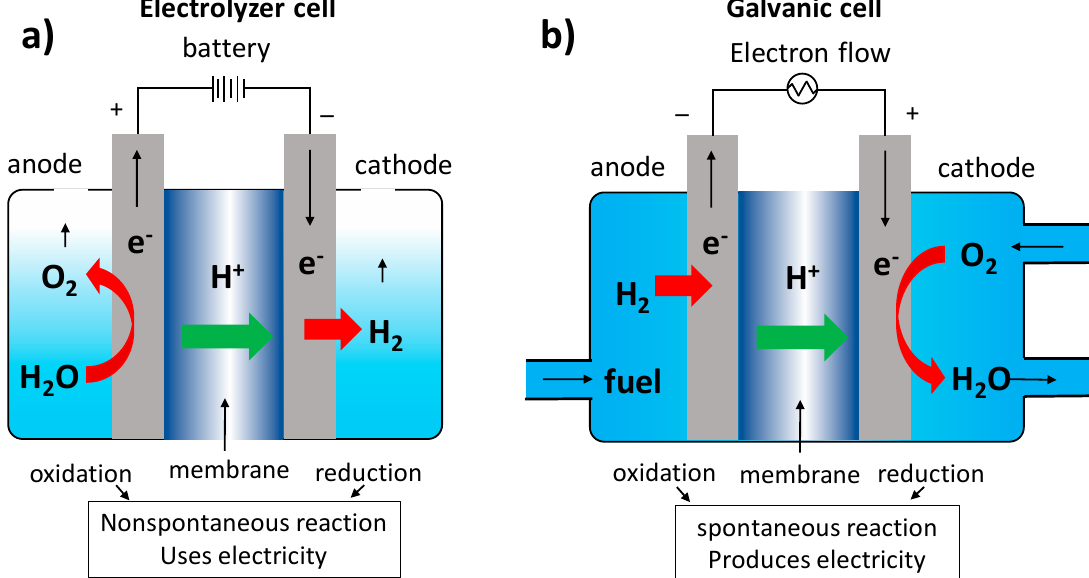
Figure 1. Components of electrochemical cells. ( a ) Electrolyzer cell (electrolytic) and ( b ) hydrogen cell (galvanic cell).